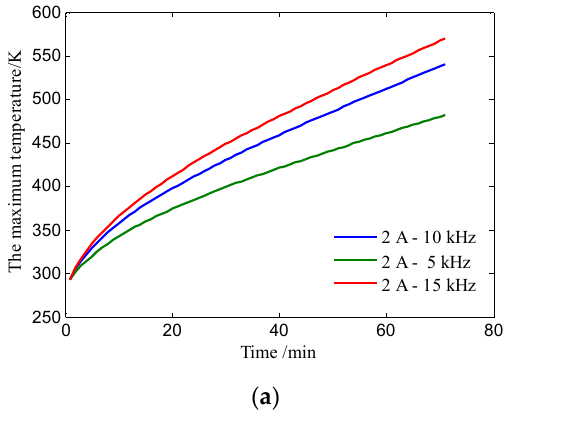
Figure 9. The performance with different current frequency. ( a ) The maximum temperature in the explosive. ( b ) The proportion of the liquid phase.